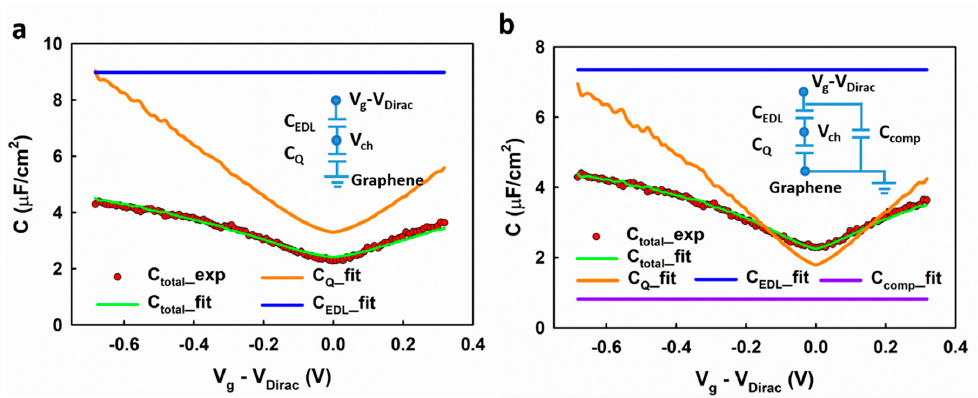
Figure 6. The fitting result of the measured interfacial capacitance using models ( a ) without and ( b ) with a compensating capacitor.